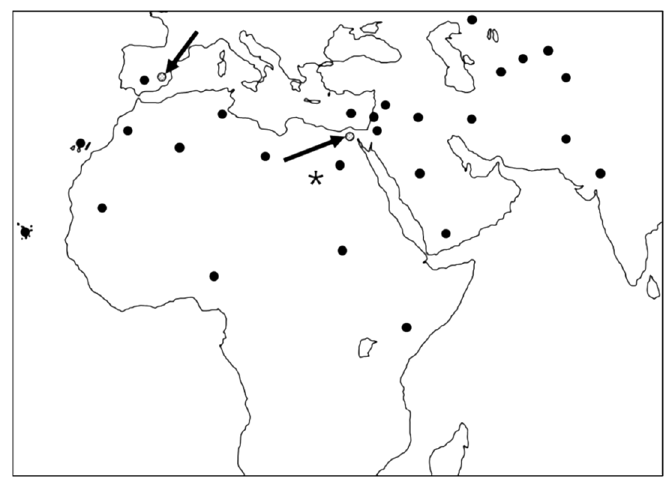
Figure 1. Geographic distribution of Orius albidipennis (Heteroptera: Anthocoridae). Countries and areas in which O. albidipennis was reported are marked with black circles ( • ) [53,63,65–67]. The two sites evaluated for suitability for O. albidipennis collection (see Tables 1 and 3) are marked with open circles ( ο ) and indicated with arrows: Albacete, Spain (latitude: 38°59 ′ 44 ″ N, altitude: ~740 m) and Giza, Egypt (latitude: 30°35 ′ 0 ″ N, altitude: ~30 m). The estimated center of distribution is marked by an asterisk ( ∗ ).